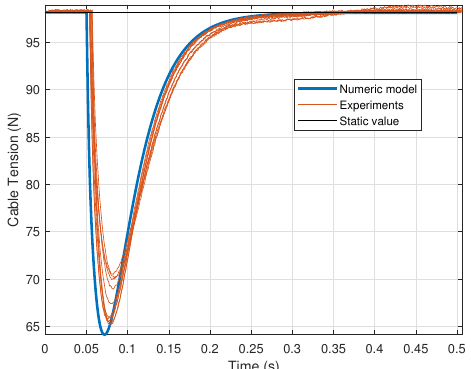
Figure 15. Results of the dynamic